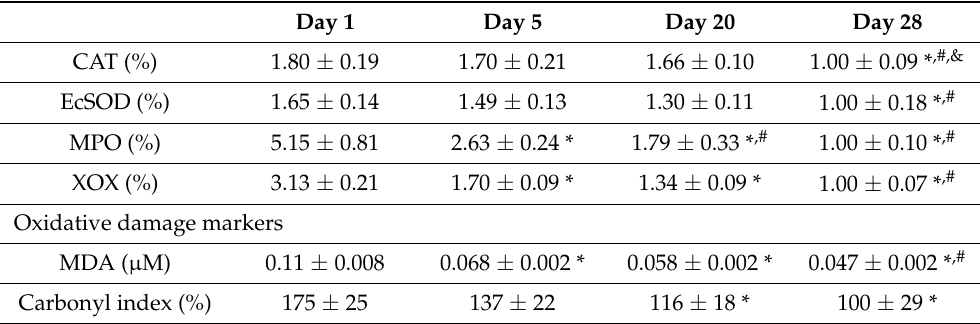
Table 2. CAT, EcSOD, MPO and XOX plasma protein levels (%) following sessions 1, 5, 20 and 28 (days) after wound recovery.